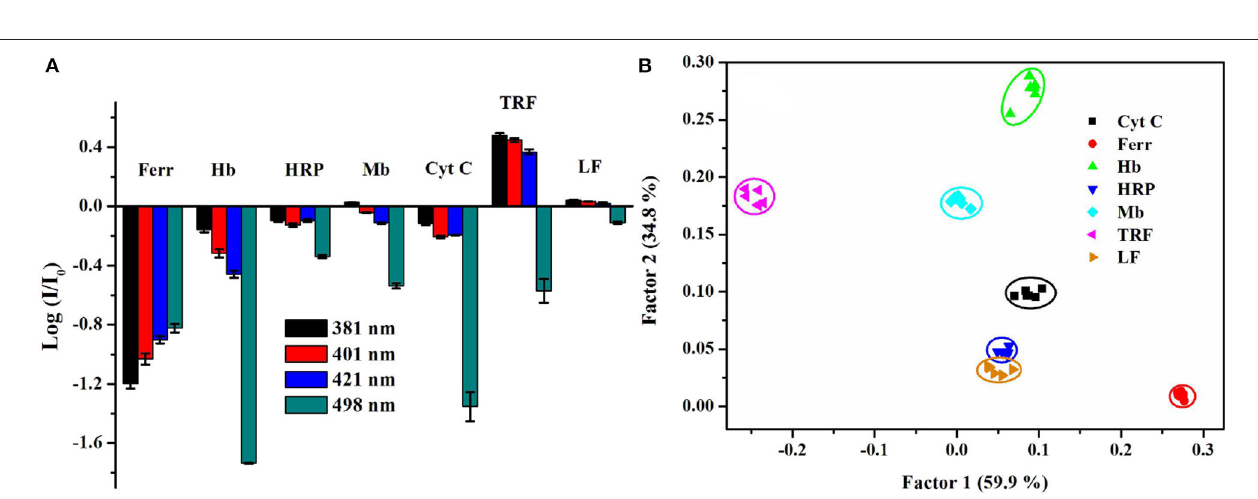
FIGURE 14 | (A) Recognition patterns for different types of metalloproteins. (B) PCA score plot for identifying metalloproteins at 0.5 µ M. Reprinted from Zheng et al. (2017) with